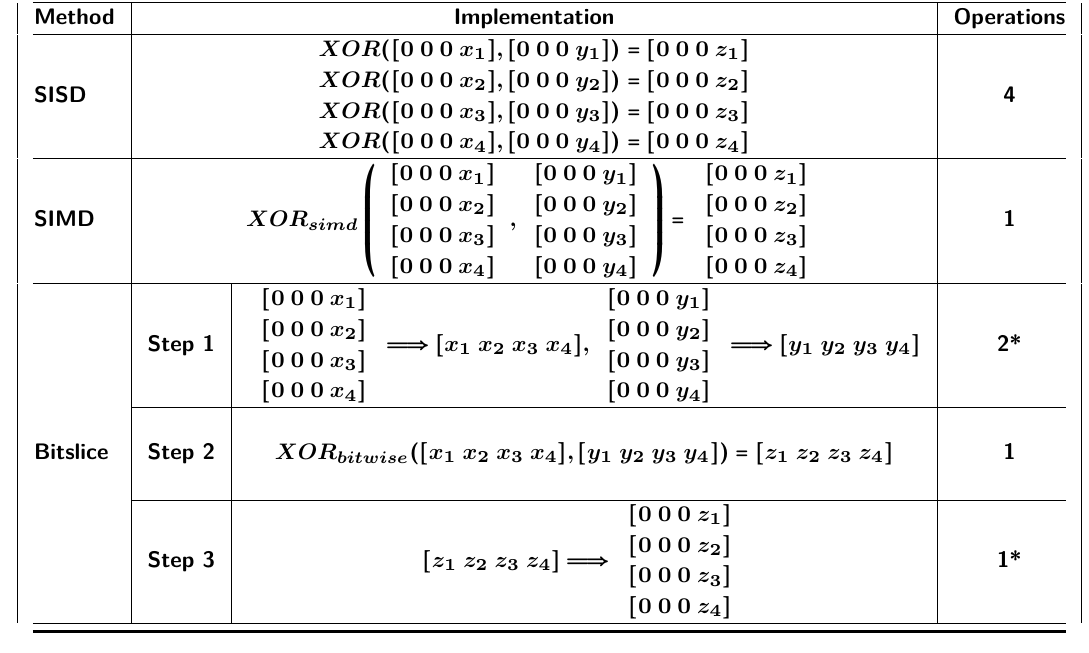
Figure 2: Comparison of SISD, SIMD and